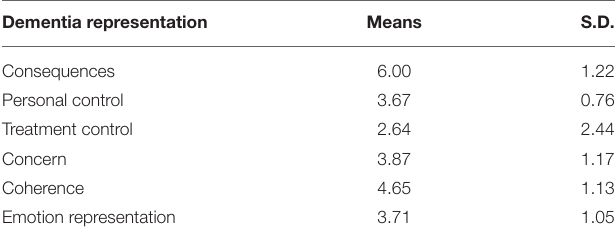
TABLE 3 | Dementia representation, empathy, and person-centered attitude predicting caregiving anger. Anger β t -value Dementia representation